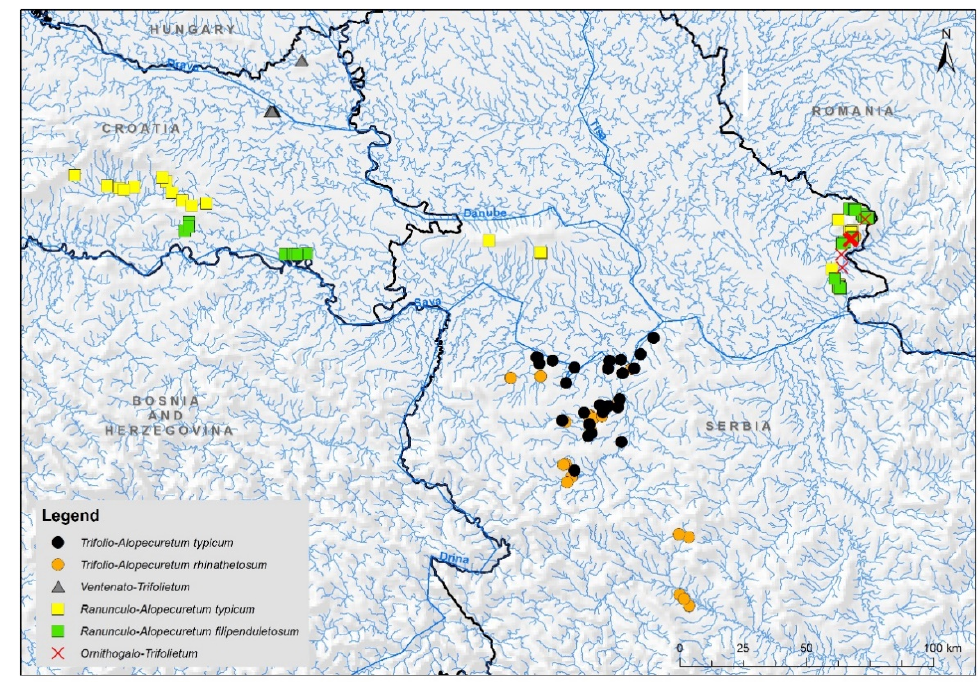
Figure 6. The geographical position of elaborated plant communities